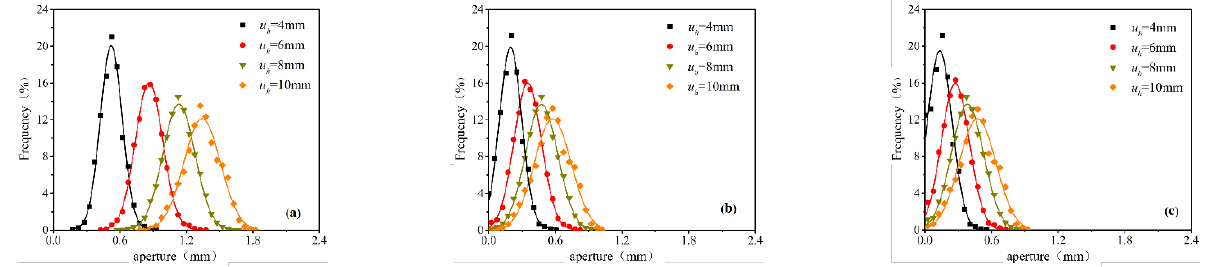
Figure 2. Gaussian distribution of aperture, ( a ) σ n 0 = 0.4 MPa; ( b ) σ n 0 = 0.8 MPa; ( c ) σ n 0 = 1.6